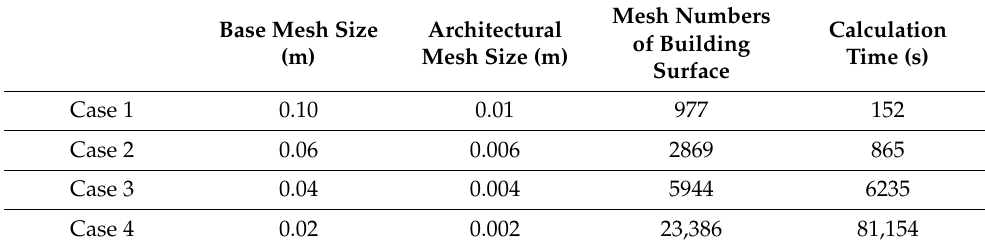
Table 2. Mesh and calculation times of 4 cases.